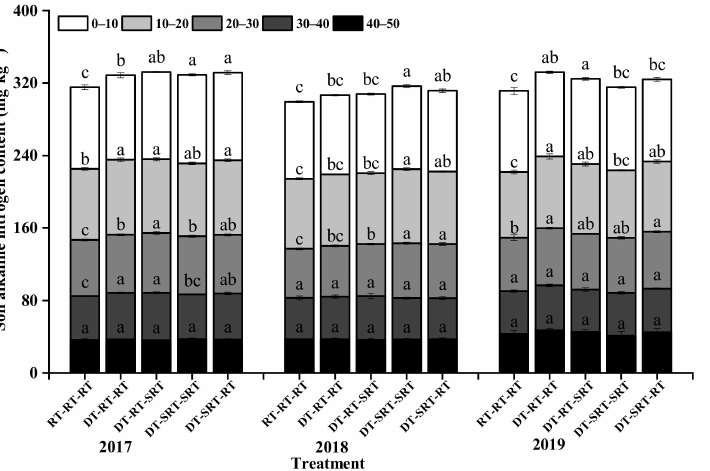
Figure 2. Soil alkaline nitrogen content in different soil layers under different treatments. Note: Different lowercase letters indicate significant differences between different treatments at the same soil layer ( p ≤